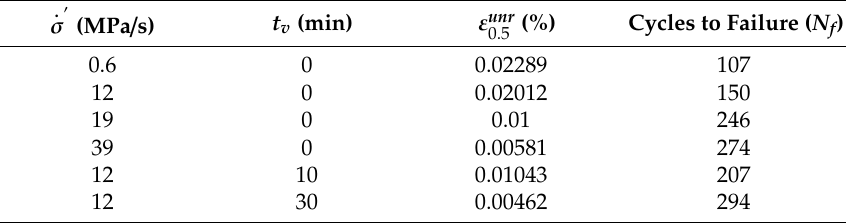
with cycles to failure. 0.5